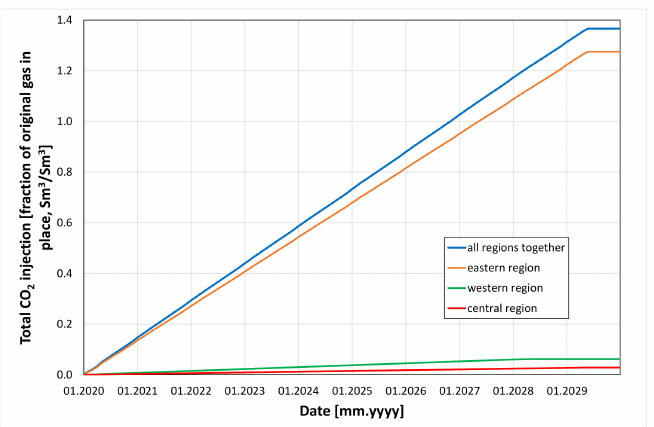
Figure 34. Regional monthly CO 2 injection.